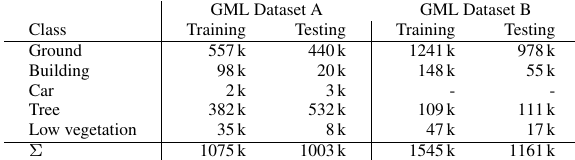
Table 1. Number of labelled 3D points in the training set and in the test set for the two parts of the GML Dataset.